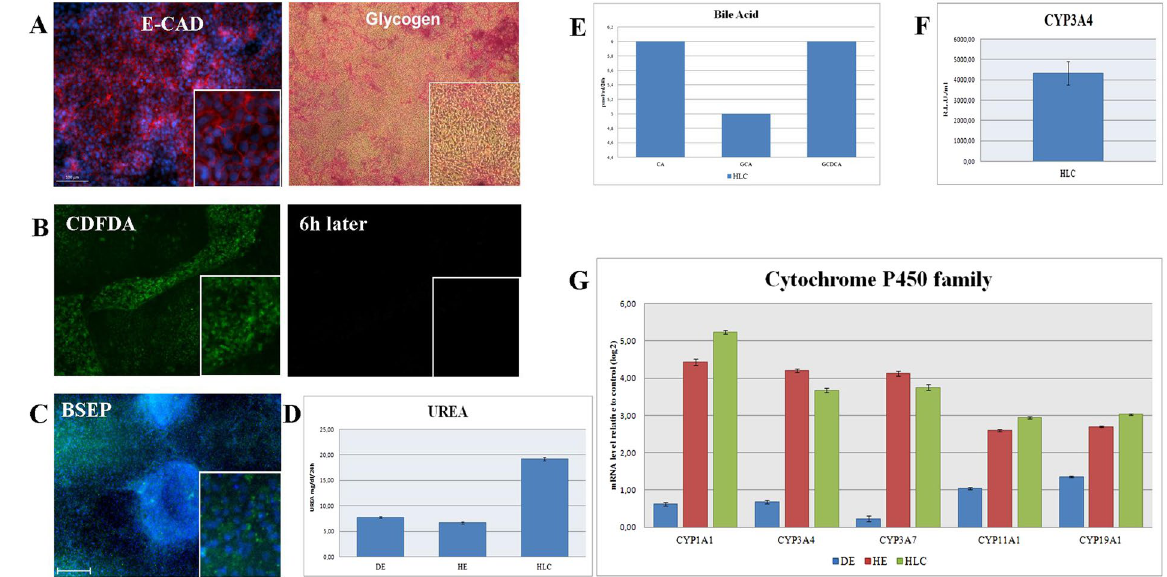
Figure 2. Functional analysis of hepatocyte-like cells (HLCs) derived from E-iPSCs. ( A ) E-Cadherin (E-CAD) antibody staining marking cell shape (left panel), Glycogen storage (right panel), Periodic Acid-Schiff (PAS) assay was used. Glycogen storage is indicated by pink or dark red-purple cytoplasm. ( B ) Visualization of 5 (and 6)-Carboxy-2 ′ ,7 ′ -dichlorofluorescein diacetate (CDFDA), immunofluorescence image of HLCs direct after incubation with CDFDA (left panel), and immunofluorescence image of HLCs six hours later (right panel). ( C ) Immunofluorescence-based protein staining of bile salt export pump (BSEP). ( D ) Analysis of UREA production in E-iPSC-DE (DE), E-iPSC-HE (HE) and E-iPSC-HLCs (HLC). Three biological replicates in technical triplicates of each sample were analyzed. The levels of urea are presented as a percentage, considering measured levels of urea in mg/dL/24 h. The error bars indicate the standard errors of the mean. ( E ) Measurement of bile acid secretion of E-iPSC-HLCs (HLC). ( F ) Measurement of CYP3A4 secretion of HLC samples. Three biological replicates in technical triplicates were analyzed. The levels of CYP3A4 are presented as relative light units per milliliter (R.L.U./ml). The error bars indicate the standard errors of the mean. ( G ) Quantitative real-time PCR (qPCR) analysis of cytochrome P450 family member activity of all stages E-iPSC-DE (DE), E-iPSC-HE (HE) and E-iPSC-HLC (HLC) are shown. Three biological replicates in technical triplicates of each sample were analyzed. The data were normalized to E-iPSCs. The standard deviation is depicted by the error